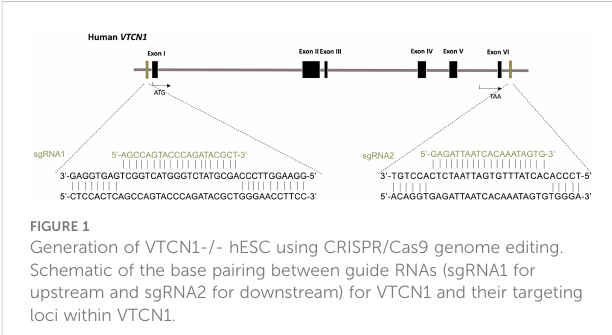
FIGURE 1 Generation of VTCN1-/- hESC using CRISPR/Cas9 genome editing. Schematic of the base pairing between guide RNAs (sgRNA1 for upstream and sgRNA2 for downstream) for VTCN1 and their targeting loci within